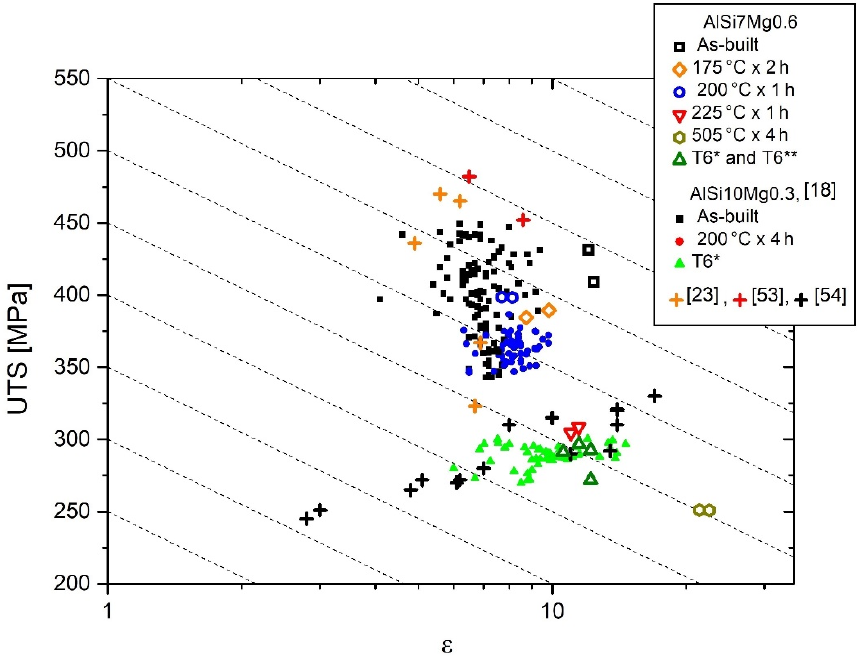
Figure 16. QI-graph where the elongation and the ultimate tensile strengths of as-built and heat-treated AlSi7Mg0.6 samples are compared to the results reported in [18]. (Adapted from reference [18]).